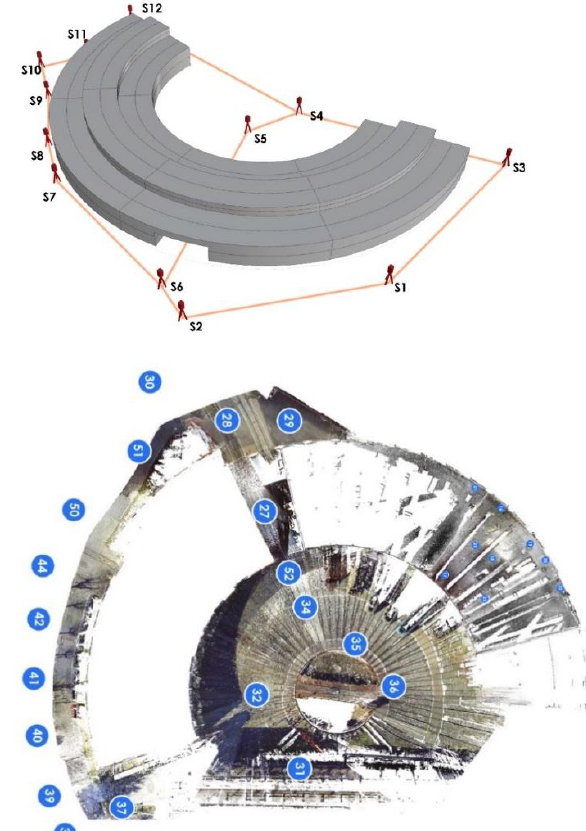
Figure 7. First order control network (above) and the registered point clouds (below).